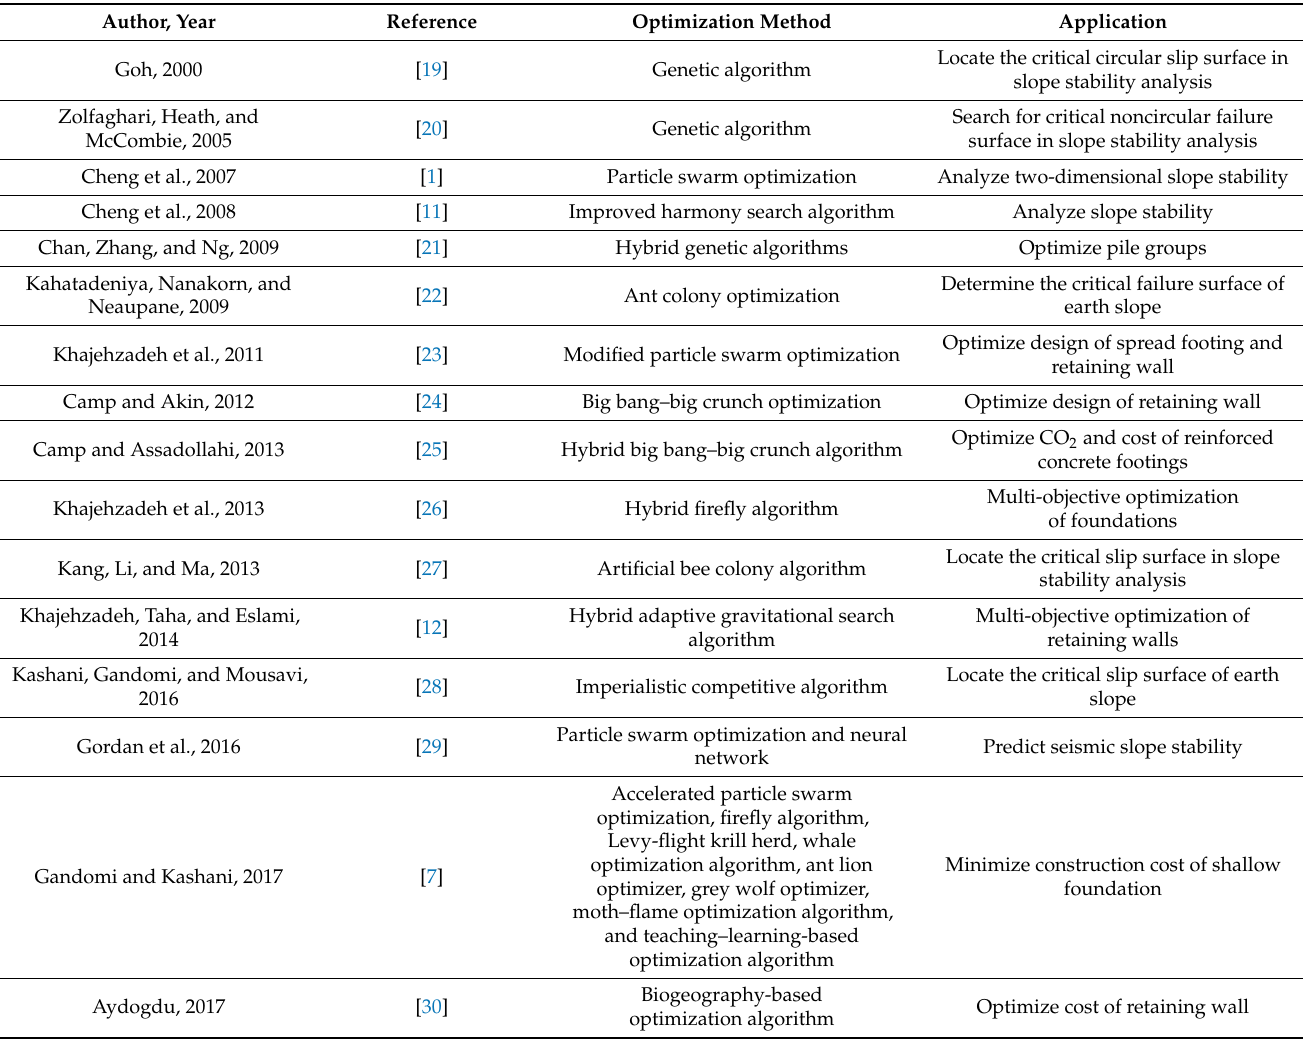
Table 1. Application of metaheuristic algorithms for geotechnical engineering